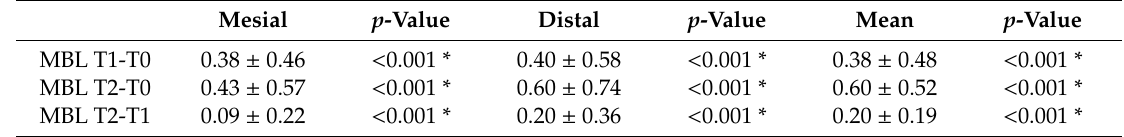
Figure 4. Implant stability pattern at baseline (T0), after 4 (T1) and 6 (T2) months of healing. ISQ: implant stability quotient; MD: mesio-distal direction; VP: vestibular-palatal direction. The mean MBL from T0 was 0.38 ± 0.48 mm at prosthesis delivery (6 months after implant insertion— T1) and 0.60 ± 0.52 mm after one year of functional loading (T2). A Wilcoxon test demonstrated significant differences in marginal bone levels between T0 and T1 and between T0 and T2 ( p < 0.001), similar results were obtained for the analysis of marginal bone level changes between T1 and T2 (0.20 ± 0.19 mm, p < 0.001). Complete MBL measurements are listed in Table 3. Table 3. Marginal bone loss at the different time points.